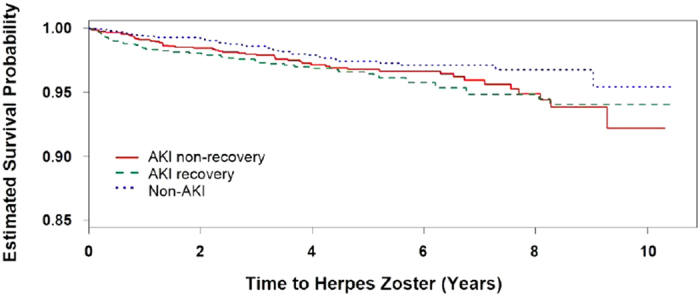
Kaplan-Meier curves of HZ-free survival.*p value for log-rank test 0.0249.